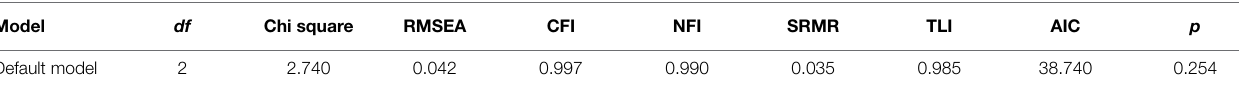
TABLE 4 | Fit indices of the CFA model of consequences of grit. Model